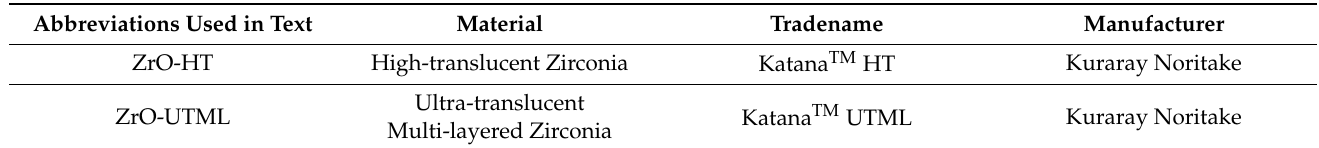
Table 1. Materials, abbreviations used in the text, and their respective manufacturer in the present study.